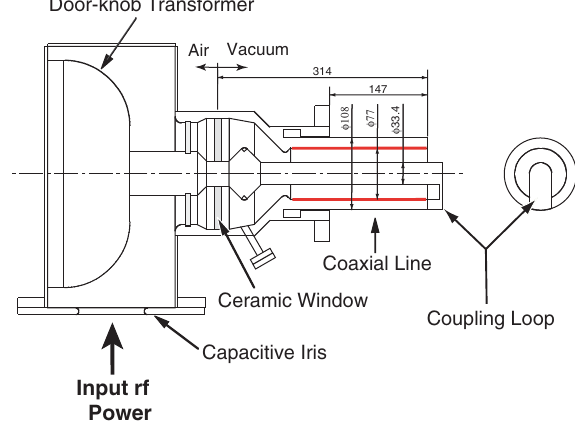
FIG. 1. Schematic diagram of the input coupler for the ARES. The red lines indicate the region where fine grooving is to be applied. The dimensions are expressed in units of